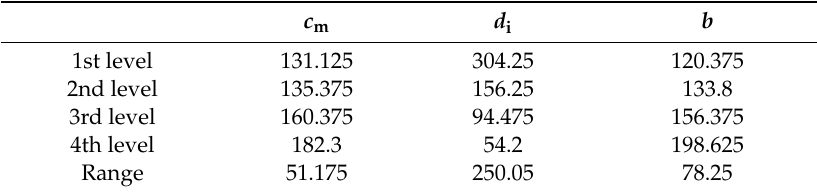
Table 7. Range analysis results.